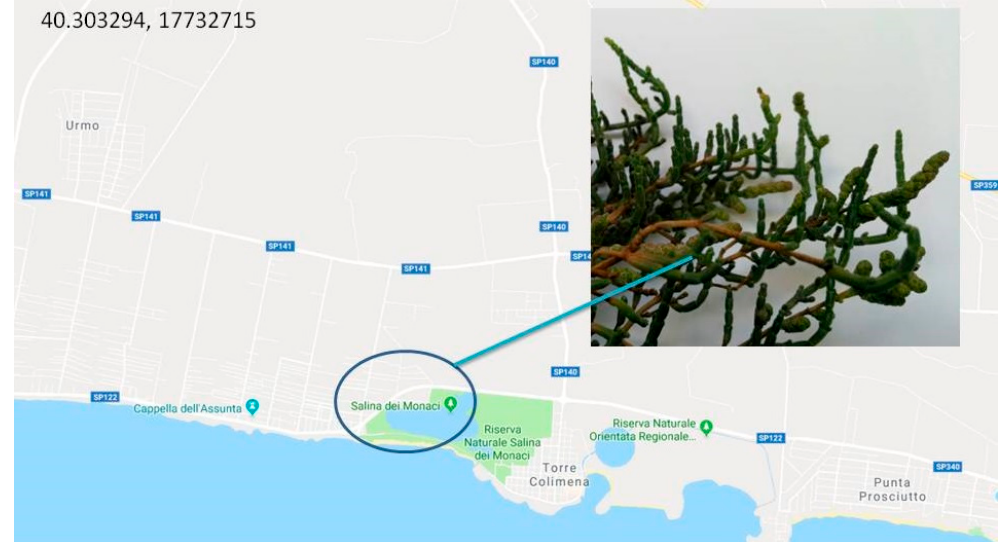
Figure 3. Adult plants of Sarcocornia sp. were harvested from Saline dei Monaci (Province of Taranto, Apulia, Italy).